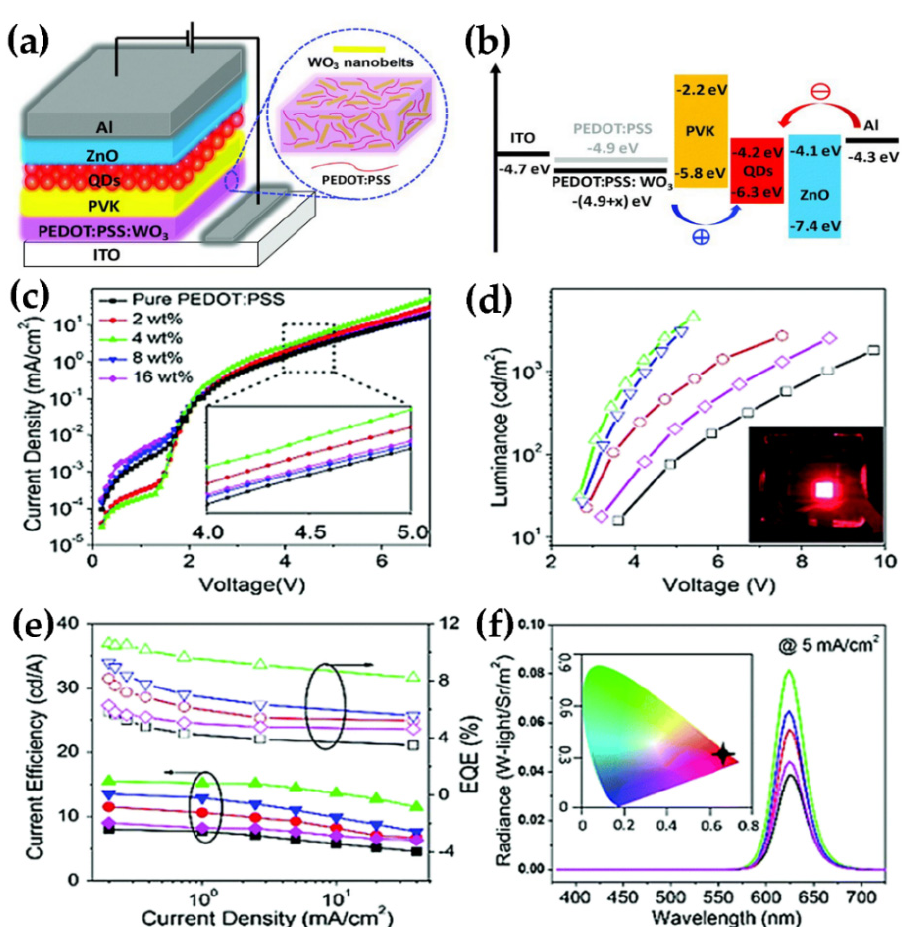
Figure 9. ( a ) Schematic device structure. ( b ) Energy level diagram of QLEDs device. ( c – f ) show the device performance of red QLEDs with different concentrations of WO 3 (0–16.0 wt.%) doped PEDOT:PSS as the hole injection layer. ( c ) Current density–voltage characteristics. ( d ) Current density–luminance characteristics. Inset: the device driven at 5 mA cm − 2 . ( e ) Current efficiency–current density–EQE characteristics. ( f ) Electroluminescence (EL) spectra at 5 mA cm − 2 . Inset: Commission Internationale de l’Eclairage (CIE) coordinates of a typical red-QLED. Reproduced or adapted from